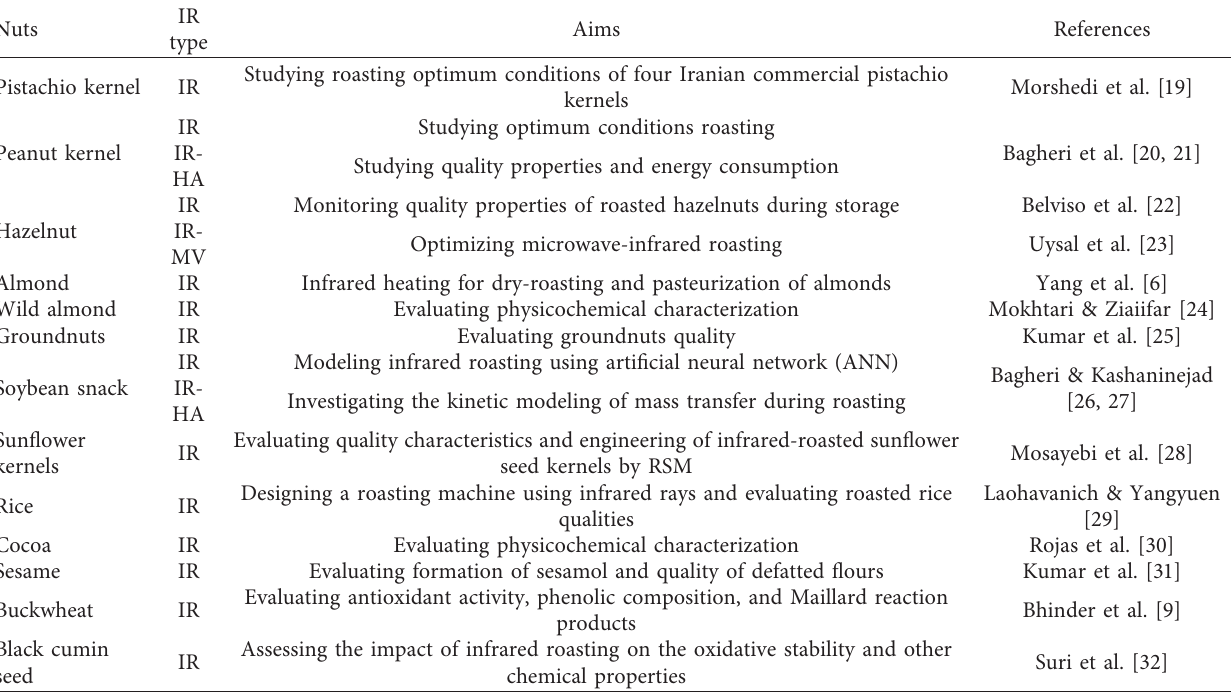
Table 1: Application of different IR roasting methods for roasting nuts and other food